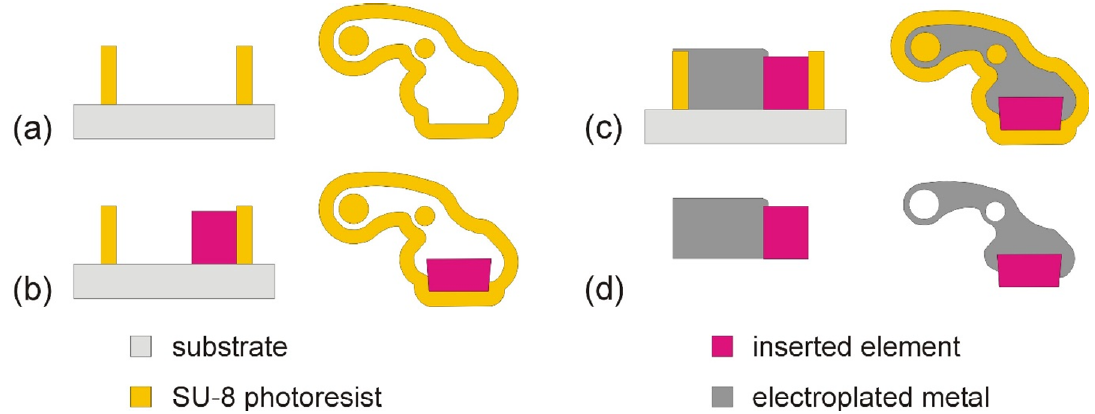
Figure 6. Process flow for the fabrication of parts with integrated elements using UV-LIGA technology: (a) SU-8 photoresist lithography for inserted element positioning and part template structuration; (b) positioning of inserted element; (c) electroplating in the photoresist template and around the inserted element; (d) removal of the substrate and photoresist to obtain the part with its integrated